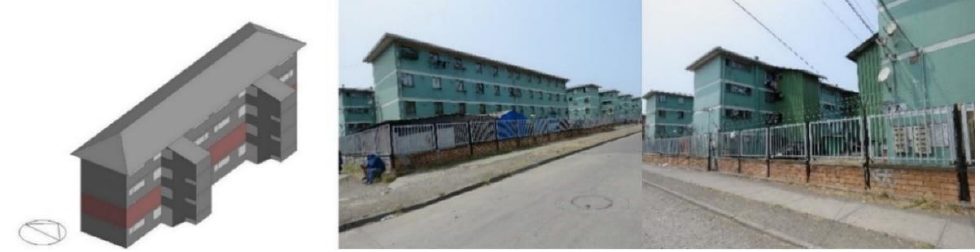
Figure A1. Geometric definition of block in DesignBuilder and terrain pictures (authors’ own preparation).